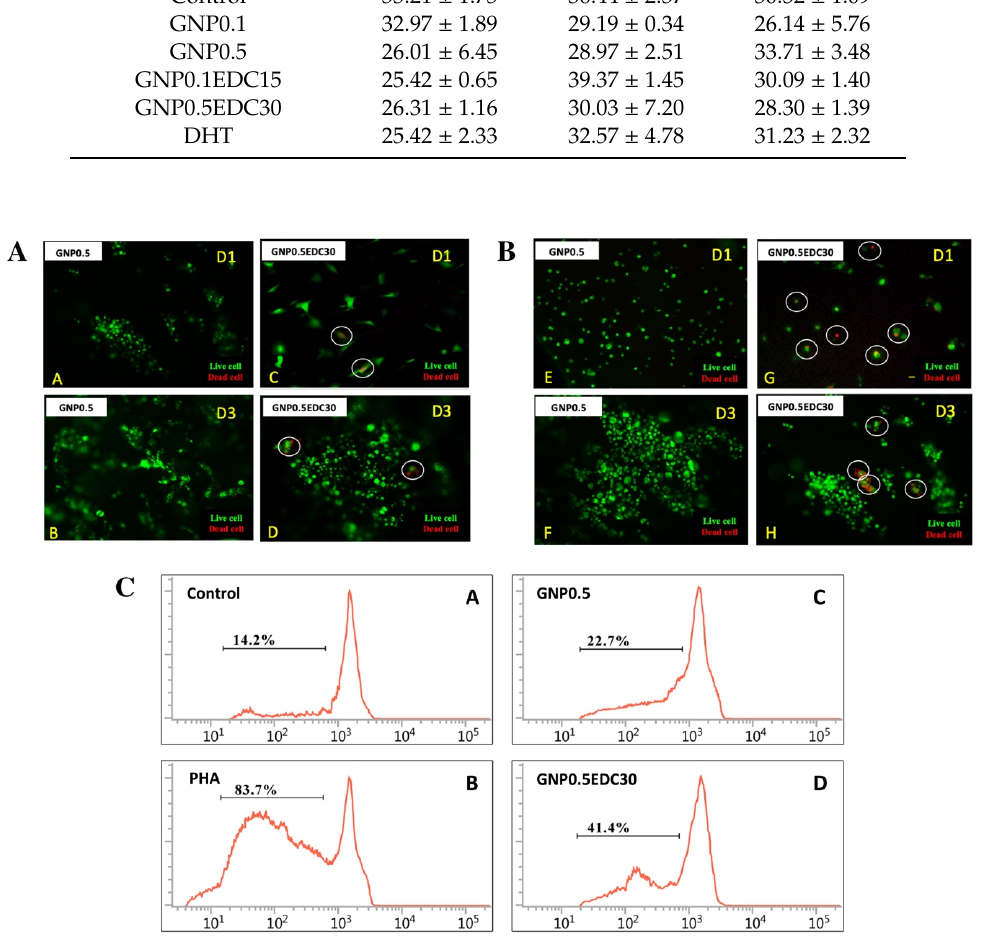
Figure 5. E ff ects of crosslinking on human epidermal keratinocytes (HEK) and dermal fibroblasts (HDF). Live / dead assay indicated the EDC crosslink sca ff olds were toxic towards skin cells compared to genipin (GNP) and dihydrothermal (DHT) crosslink sca ff old. ( A ) HDF cells and ( B ) HEK cells seeded on GS crosslink with GNP0.5 / GNP0.5EDC30 at day 1 (D1) until day 3 (D3) (100X magnification). The white line circle indicates the dead cells. E ff ects of crosslinking on immunogenicity. ( C ) Proliferation properties of peripheral blood mononuclear cells (PBMCs) in medium supplemented with GS extracts in